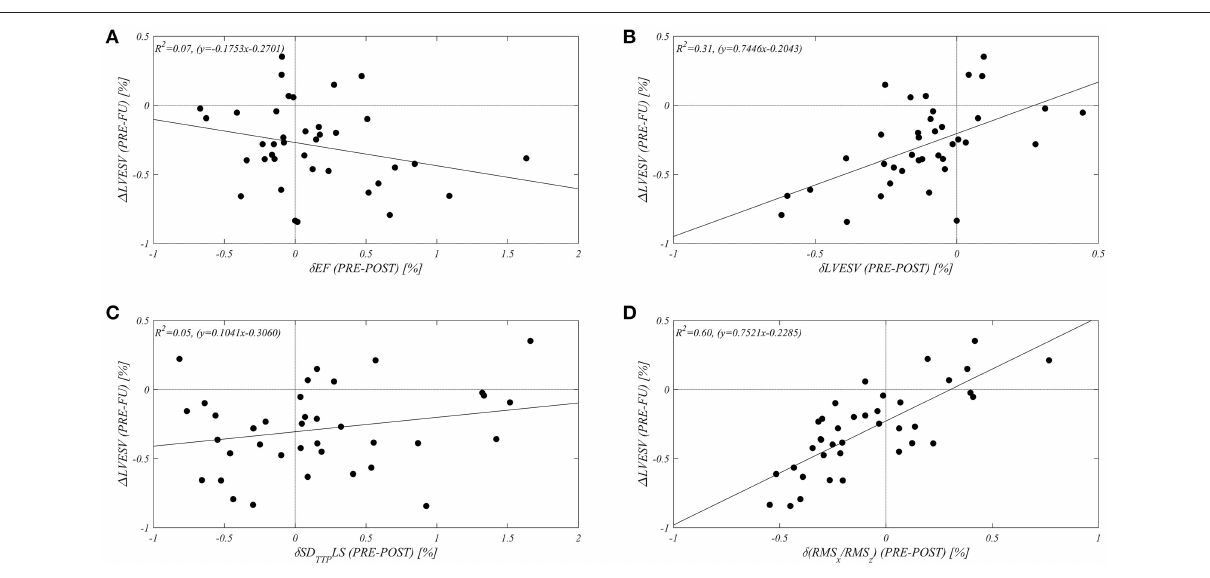
FIGURE 2 | Different Correlations between early changes (expressed by “ δ ”: from echo PRE CRT implant to echo POST) of selected echocardiographic parameters [ (A) LVEF, (B) LVESV, (C) SD TTP LS, (D) RMSx/RMSz], with relative long term variation of LVESV at midterm follow up( 1 LVESV %).